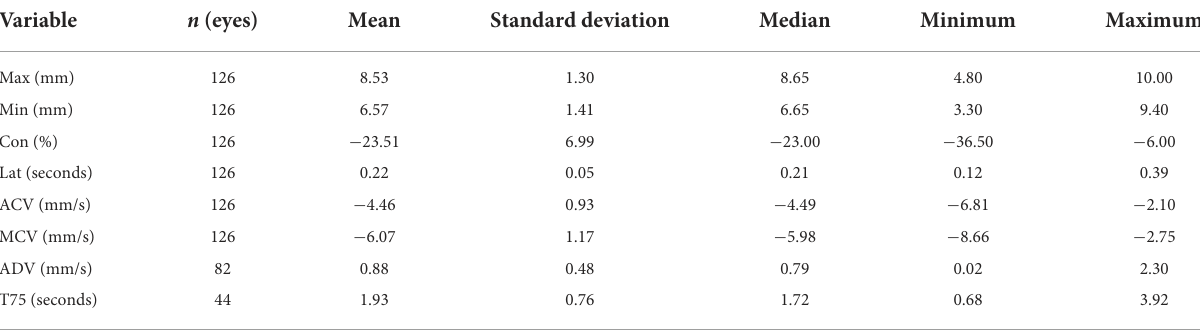
TABLE 1 Summary statistics for pupillometry measurements.